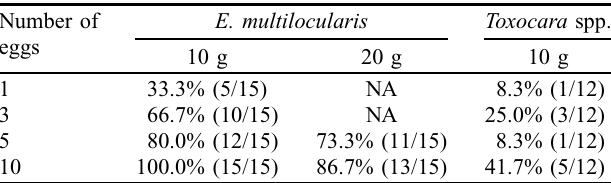
Table 1. Method sensitivities (in %) of the flotation/sieving method combined with DNA extraction and detection by real-time PCR for E. multilocularis and Toxocara spp. in soil samples (10 g or 20 g). For each number of eggs, 15 and 12 samples were used for E. multilocularis and Toxocara spp., respectively. Number of E. multilocularis Toxocara spp. eggs